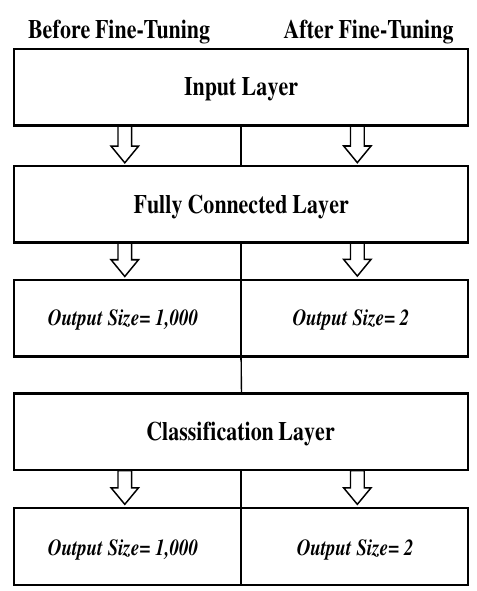
Figure 6. The three fine-tuned layers for every pre-trained